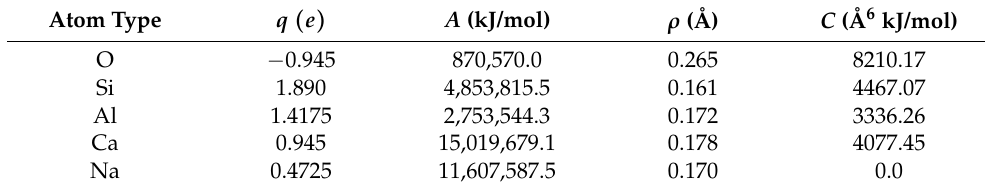
Table 1. Coefficients of Guillot-Sator model [27] for various coal ash systems.